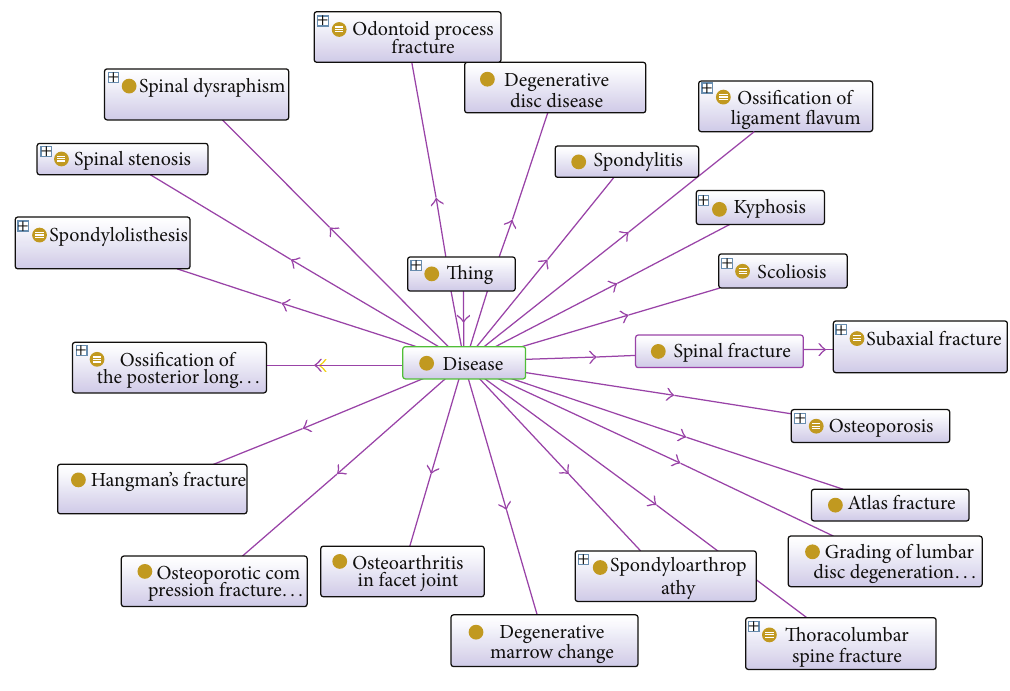
Figure 2: List of the spinal diseases shown in Prot´eg´e.